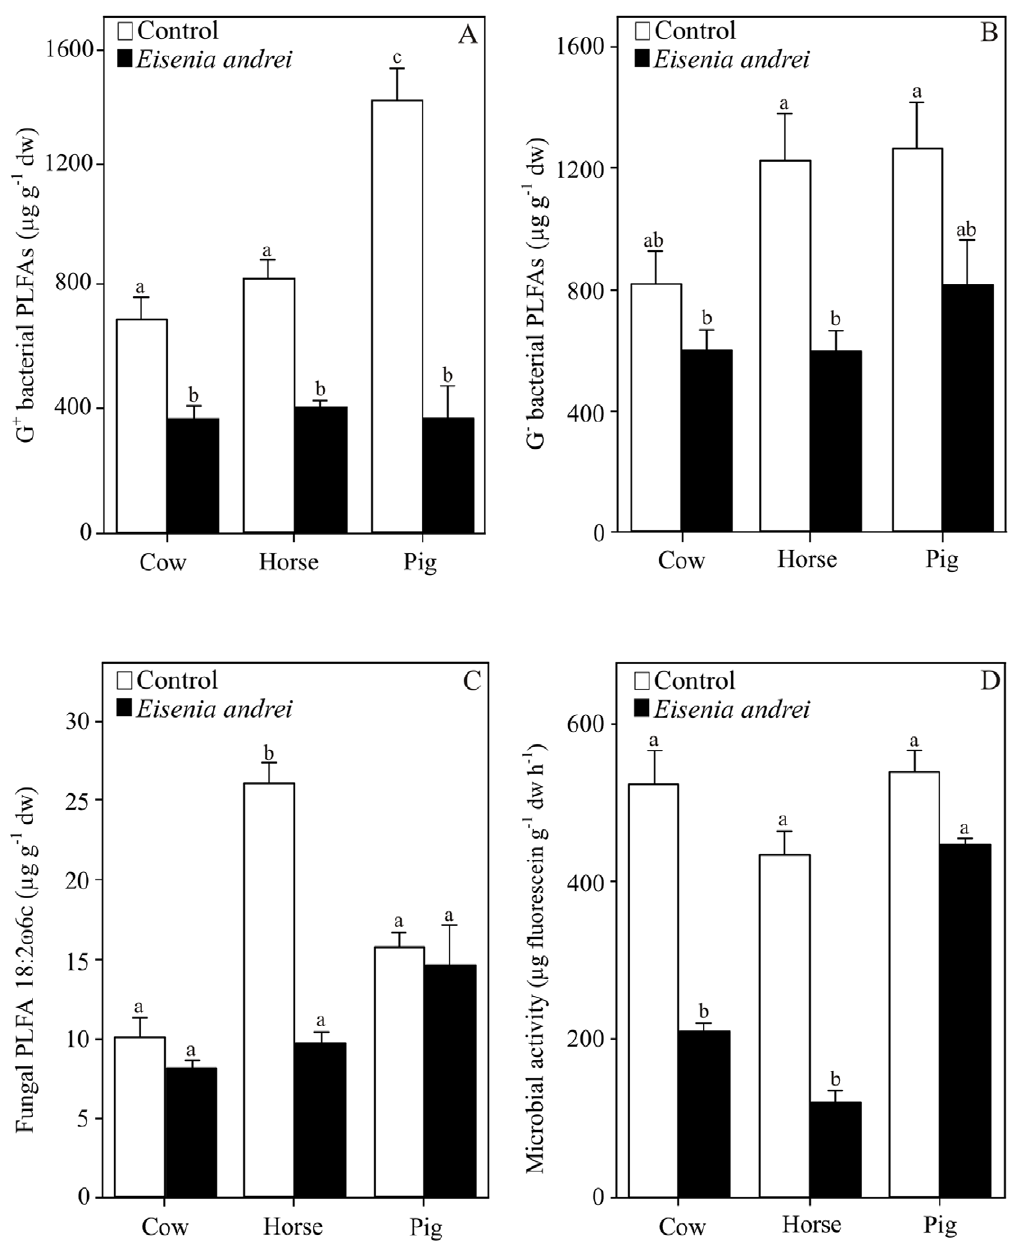
Figure 1. Changes in (A) Gram-positive bacterial PLFAs, (B) Gram-negative bacterial PLFAs, (C) fungal PLFA 18:2 v 6c and (D) microbial activity assessed by fluorescein diacetate hydrolysis, after the passage of the three different animal manures (cow, horse and pig) through the gut of the earthworm species Eiseniaandrei . Values are means 6 SE (n=5). Different letters indicate significant differences between samples (Tukey HSD test; a =0.05). Controls are the manures incubated without